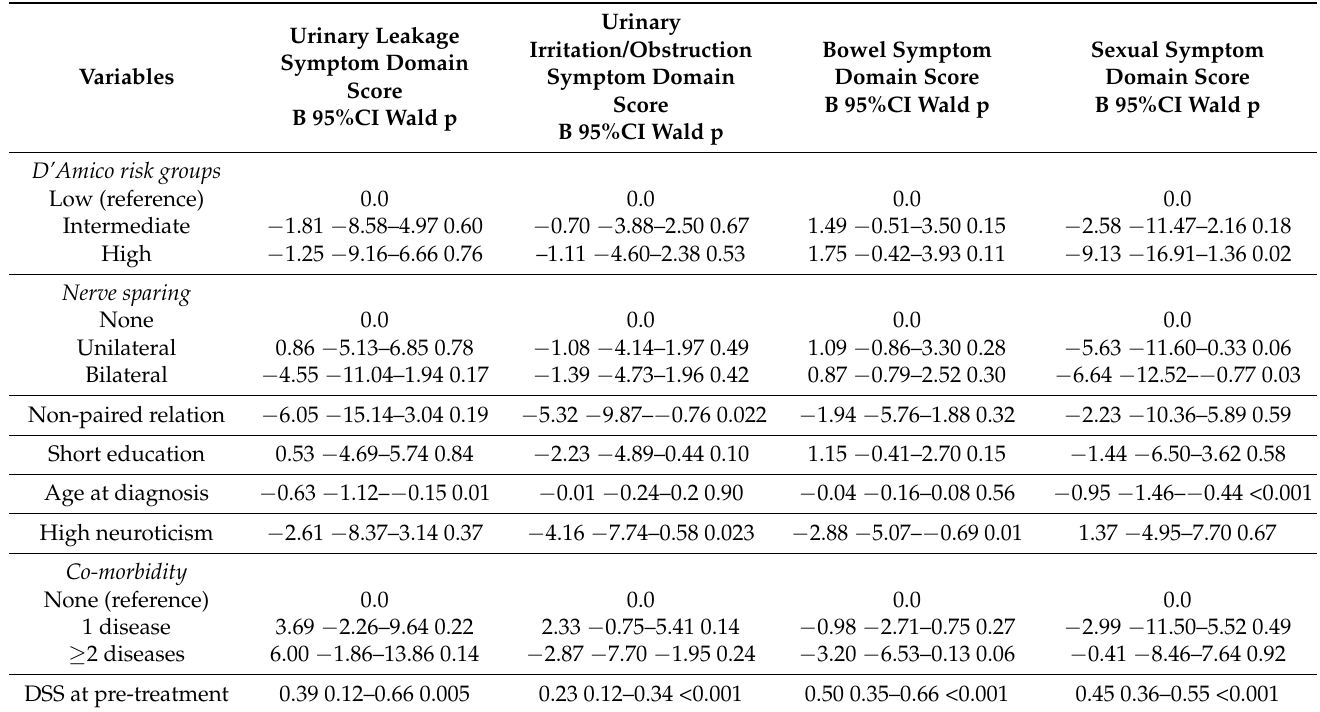
Table 4. General estimating equations (GEEs) estimates of predictors of domain summary scores (DSSs) at 3-year